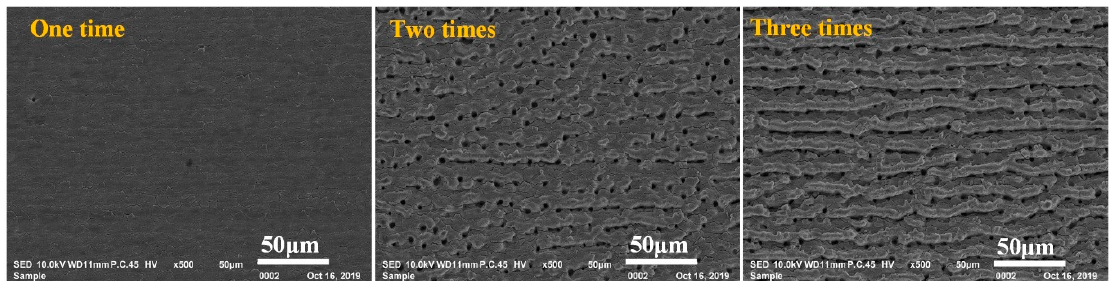
Figure 6. ( a ) Effect of F p2 on the roughness R a of two-step laser-irradiated surfaces; The illustration for roughness testing on the ( b ) first-step laser-irradiated and ( c ) two-step laser-irradiated surfaces.